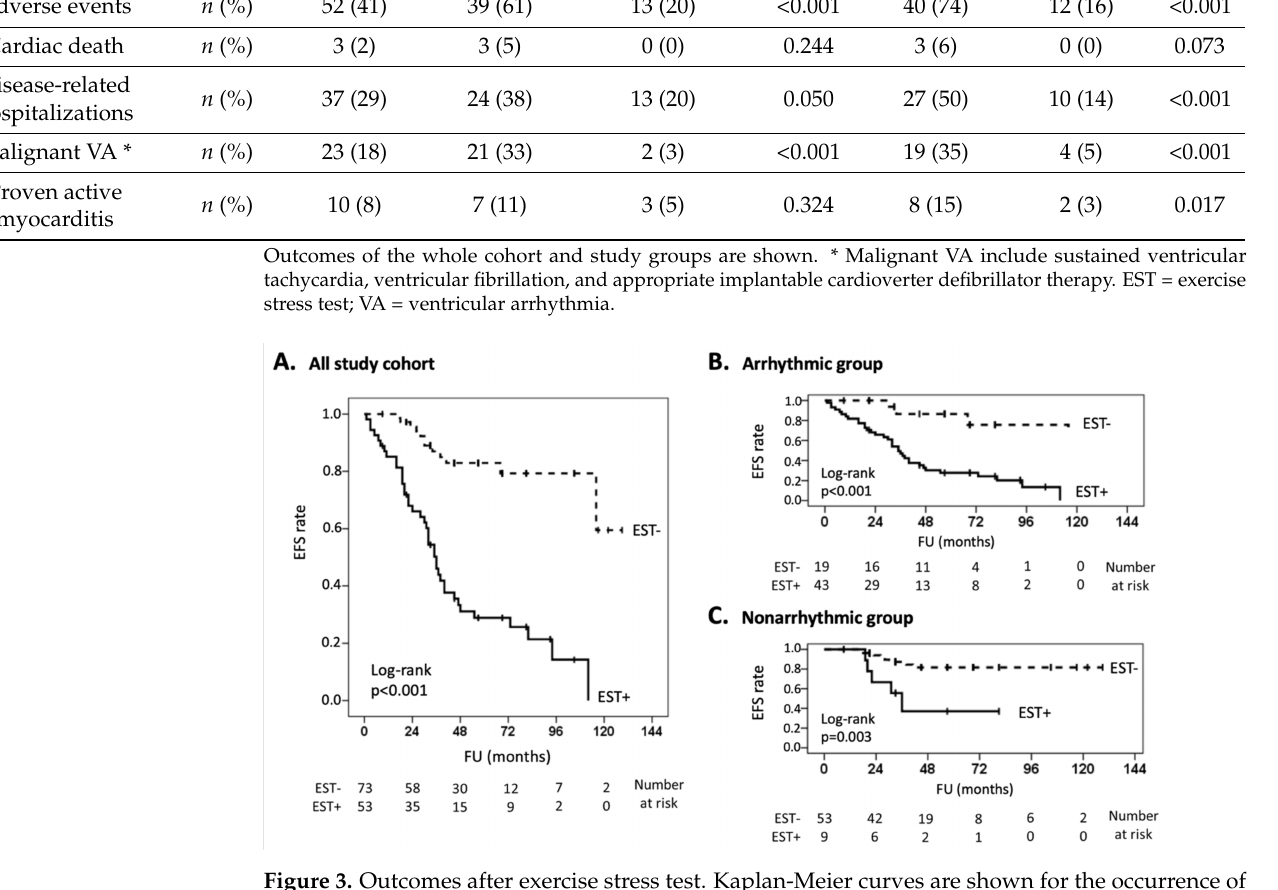
Figure 3. Outcomes after exercise stress test. Kaplan-Meier curves are shown for the occurrence of adverse events after EST. Adverse events included cardiac death, disease-related hospital readmis- sions, malignant ventricular arrhythmia (sustained ventricular tachycardia, ventricular fibrillation, appropriate implantable cardioverter defibrillator treatment), and active myocarditis, proven by endomyocardial biopsy or myocardial imaging. For each graph, x -axis indicates follow-up months after EST, and y -axis indicates event-free survival. The continuous line refers to patients with EST positive for ventricular arrhythmia or ischemia (EST+), whereas the dashed line refers to patients with uneventful EST (EST-). Numbers at risk are reported below each chart. Curves are shown for the whole patient cohort (panel ( A )) and arrhythmic and nonarrhythmic subgroups (panels ( B , C ), respectively). EFS = event-free survival; EST = exercise stress test; FU = follow-up. Of 47 patients with VA documented during EST, 35 (74%) underwent myocarditis restaging either by CMR ( n = 19), FDG-PET ( n = 15), or EMB ( n = 8): prevalence of polymorphic and/or irregular VA during EST were observed in patients with